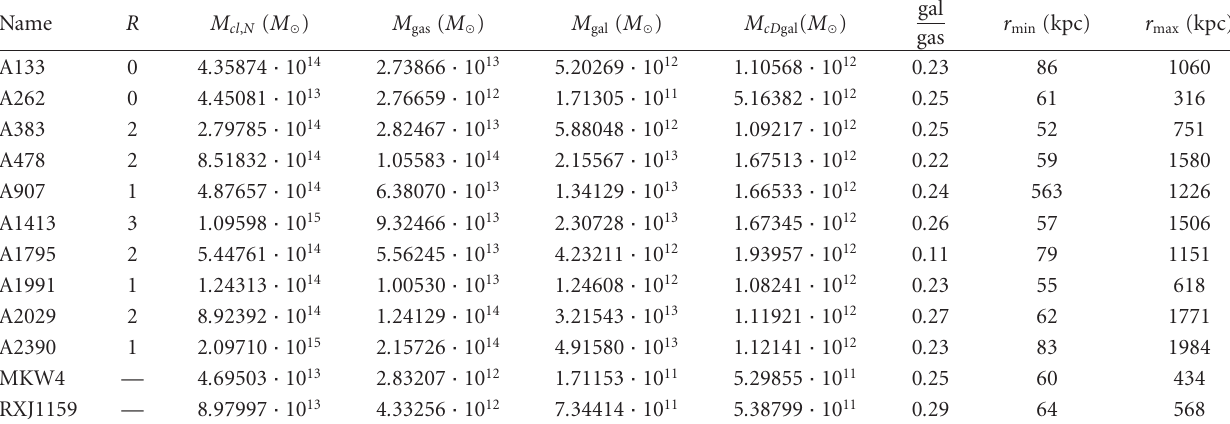
Table 1: Column 1: Cluster name. Column 2: Richness. Column 3: cluster total mass. Column 4: gas mass. Column 5: galaxy mass. Column 6: cD-galaxy mass. All mass values are estimated at r = r max . Column 7: ratio of total galaxy mass to gas mass. Column 8: minimum radius. Column 9: maximum